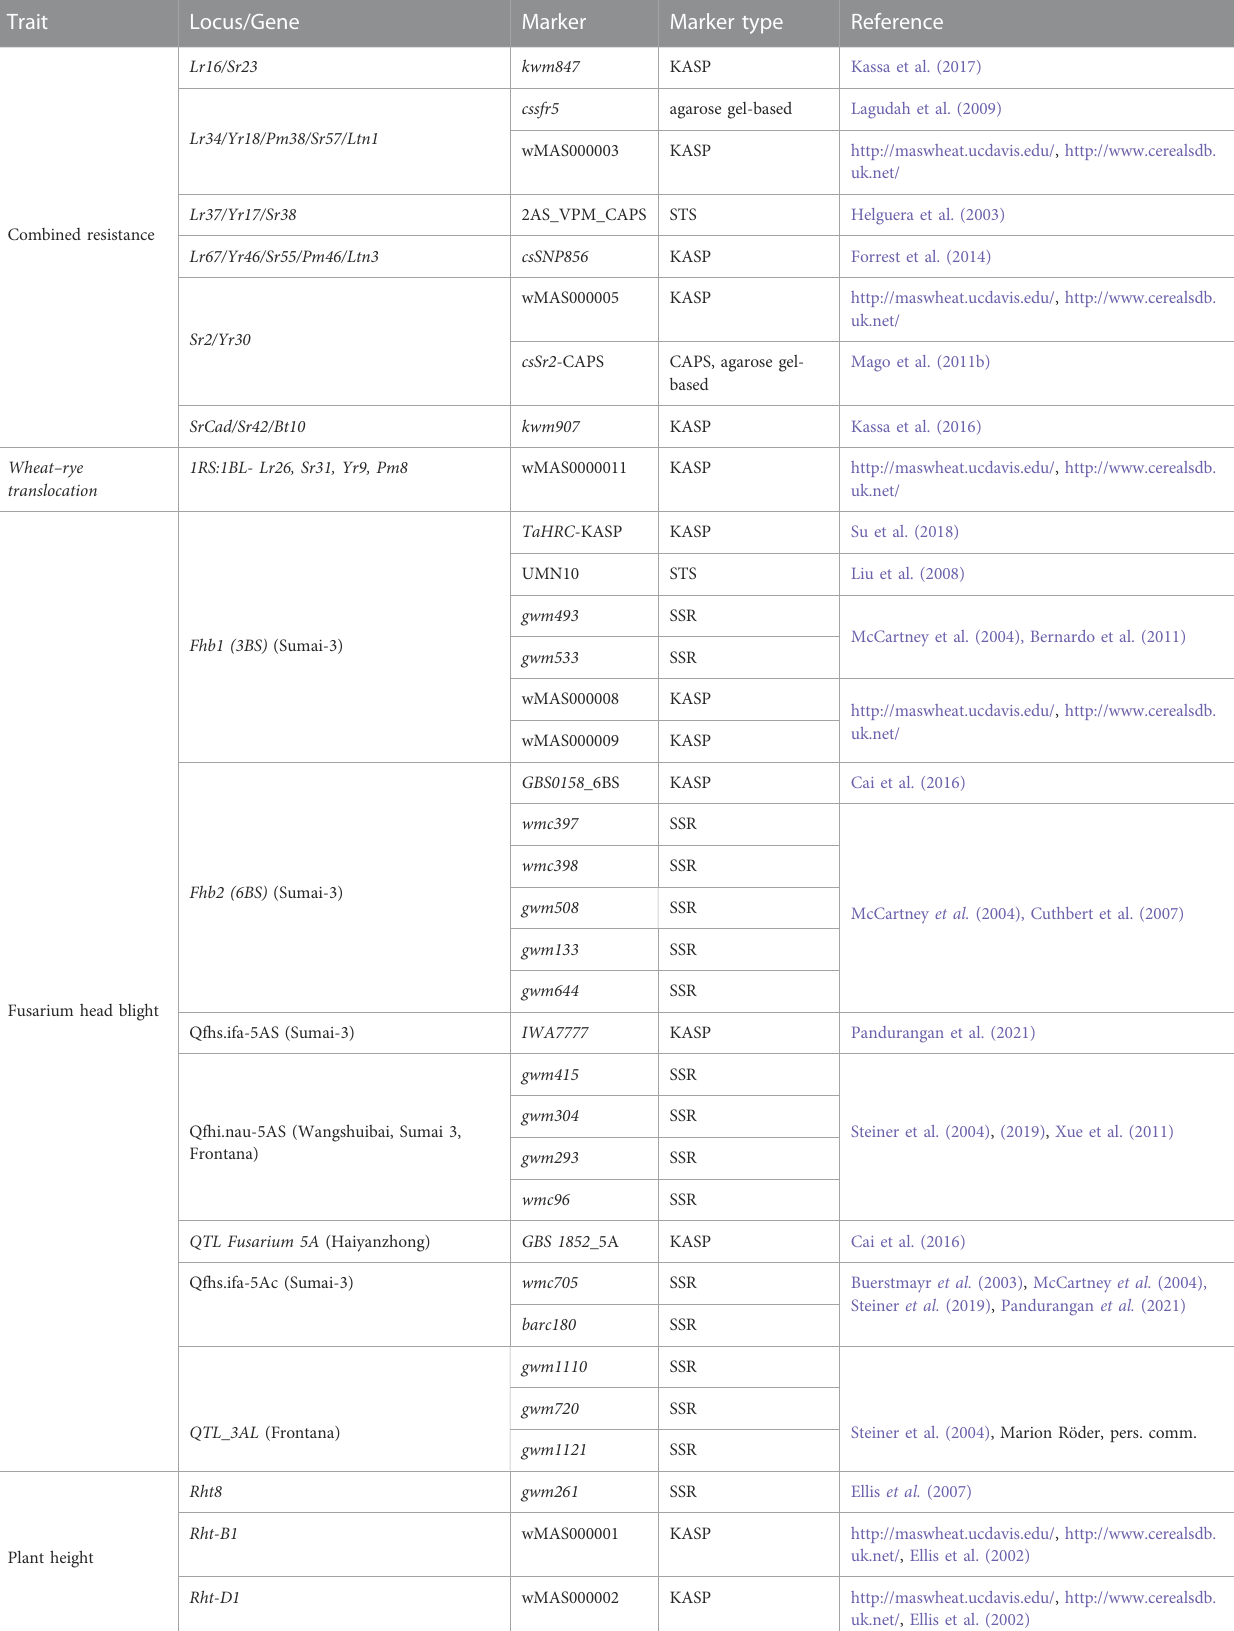
TABLE 1 Molecular markers analysed in the Brazilian material to predict the presence of speci fi c loci/genes (Röder et al., 1998; Dreisigacker et al.,